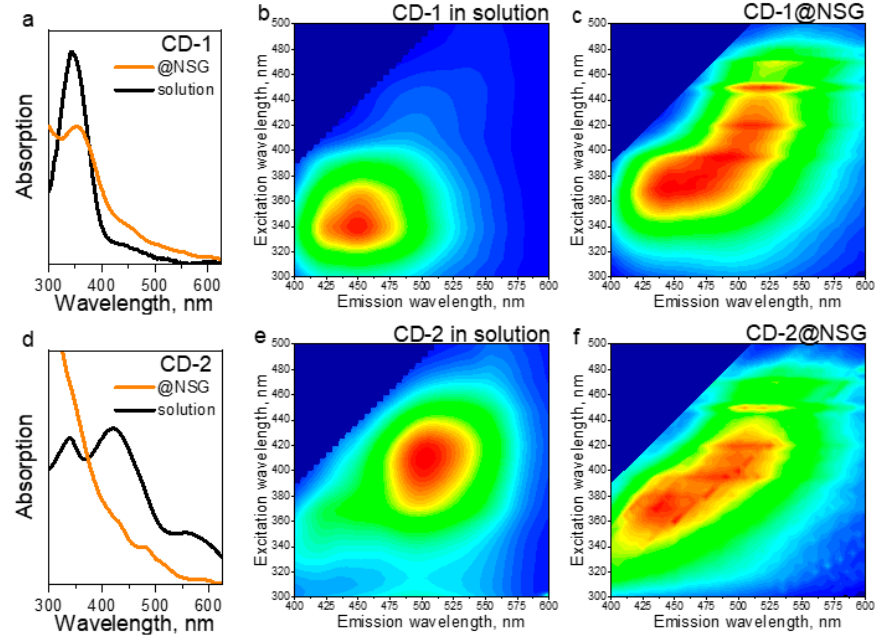
Figure 4. ( a , d ) Absorption spectra of CD-1 and CD-2 in solution (black) and embedded in NSG (orange). PLE-PL maps of ( b , c ) CD-1 and ( e , f ) CD-2 in solution ( b , e ) and in NSG ( c , f ).